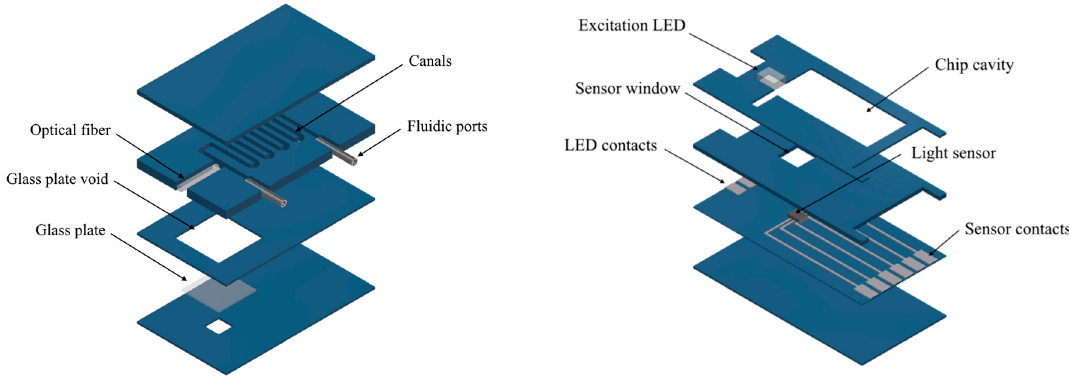
Figure 6. The two-component microfluidic system for fluorescence measurements: the microfluidic chip ( left ) and base station ( right ).